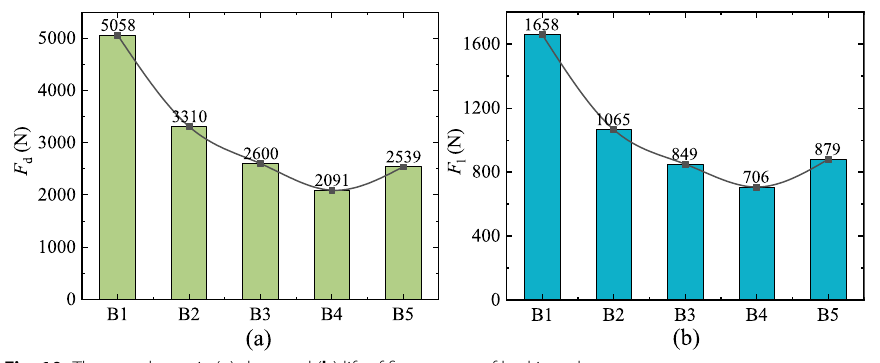
Fig. 10 The aerodynamic ( a ) drag and ( b ) lift of five groups of braking